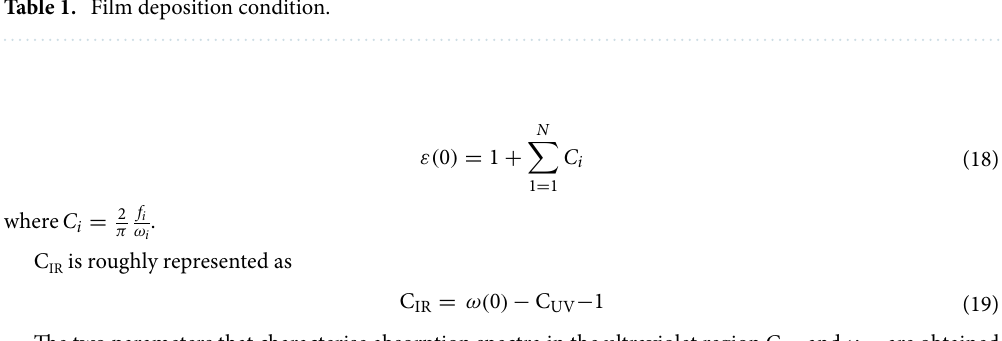
Table 1. Film deposition